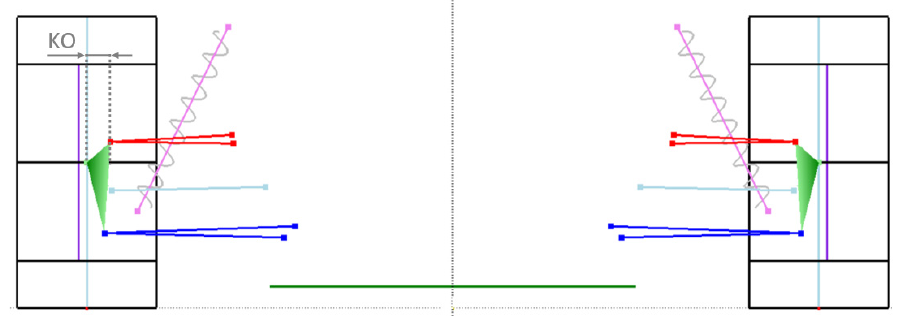
Figure 10. Schematic front view (yz plane) of the EB0 suspension, KO (Kingpin Offset) is halved.